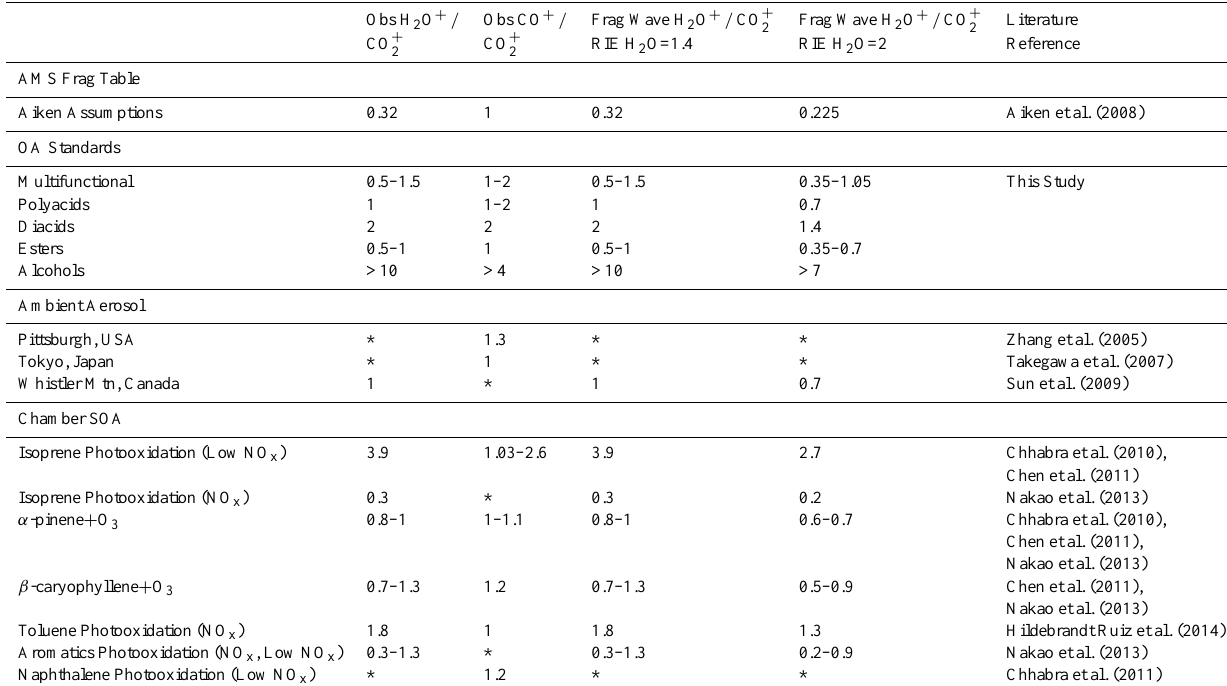
Table 2. Summary of fragment ion ratios observed for standard molecules, chamber SOA, and ambient SOA. The entry * denotes the use of Aiken assumptions for the ratio in the fragment